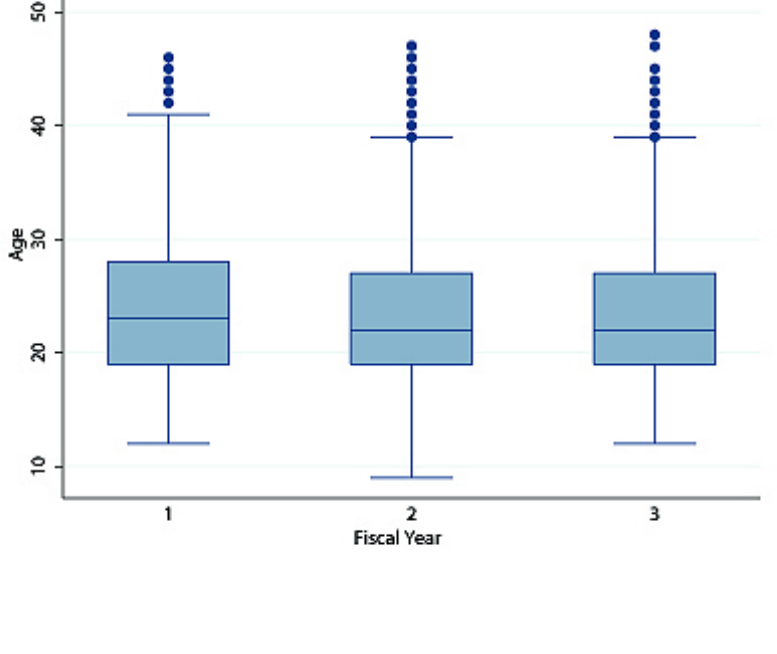
Figure 1. Box plot of respondents’ages who owned mobile phones by fiscal